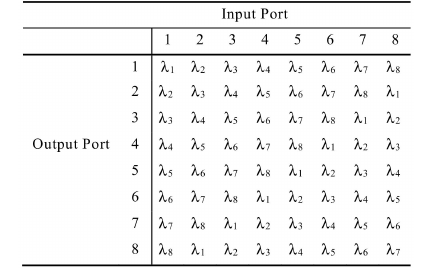
Figure 1. The configuration of proposed optical routing system. OC = optical circulators, AWG = arrayed waveguide gratings, SW = optical switches. Table 1. 8 × 8 cyclic AWG routing rule.